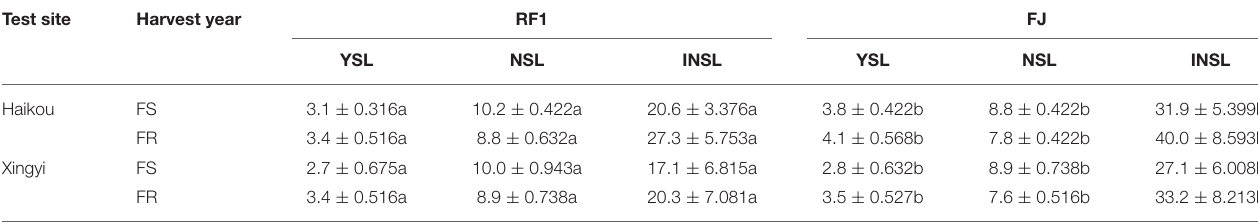
TABLE 5 | Comparison of banana resistance to Sigatoka disease in RF1 and FJ grown at two experimental filed sites. Test